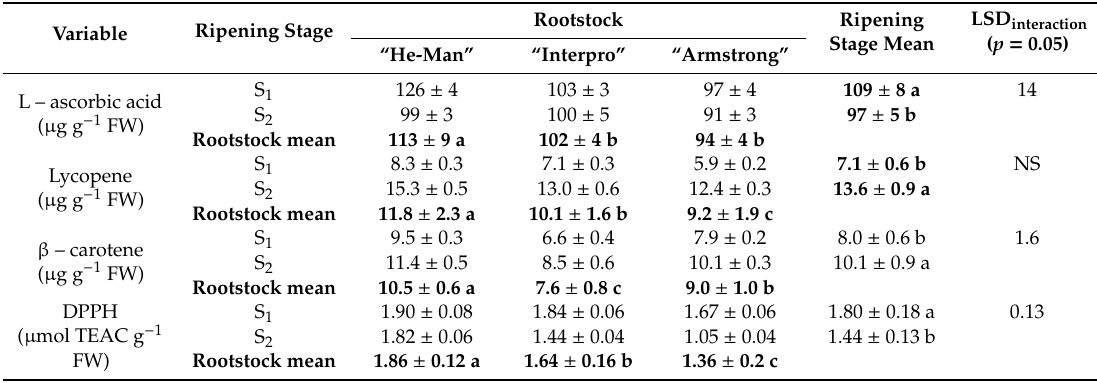
Table 4. L—ascorbic acid, main carotenoids content and antioxidant activity in tomatoes “Sir Elyan” as a ff ected by rootstock and ripening stage (mean ± standard error). Di ff erent letters among factor means (bold numbers) indicate significance at Fisher’s LSD test ( p = 0.05). NS: not